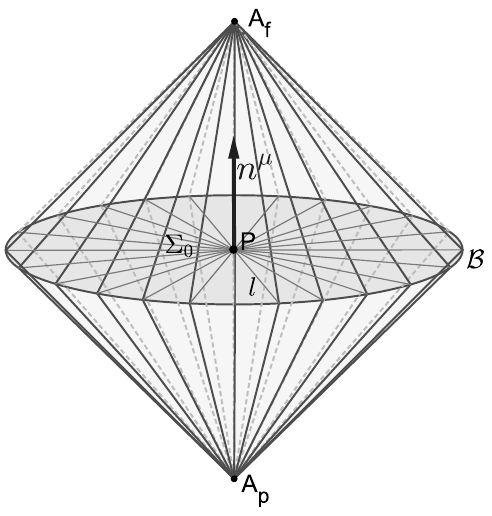
Figure 1 . A sketch of a GLCD with the origin in point P (the angular coordinate θ is suppressed). Σ 0 is a spatial geodesic ball of radius l (several of the geodesics forming it are depicted as grey lines), its boundary an approximate 2-sphere . Unit timelike vector n µ is a normal of Σ 0 . The B tilted lines from the past apex A p ( t = l/c ) to the future apex A f ( t = l/c ) represent the null − geodesic generators of the GLCD boundary. The diamond’s base Σ 0 is the spatial cross-section of both the future domain of dependence of A p and the past domain of dependence of A f at t =